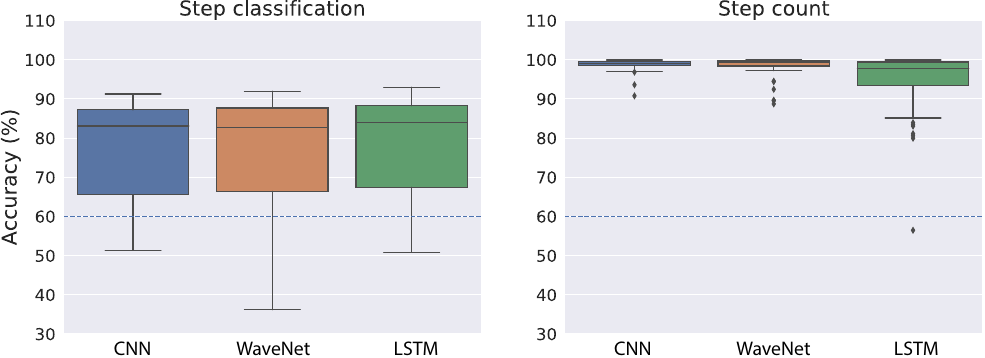
Figure 7. Cross-validation results on the public dataset using ENMO as the input to neural network models. The accuracy measures were taken from 70 shuffled splits of training and validation sets. The dashed blue line indicates performance achieved from a previous study